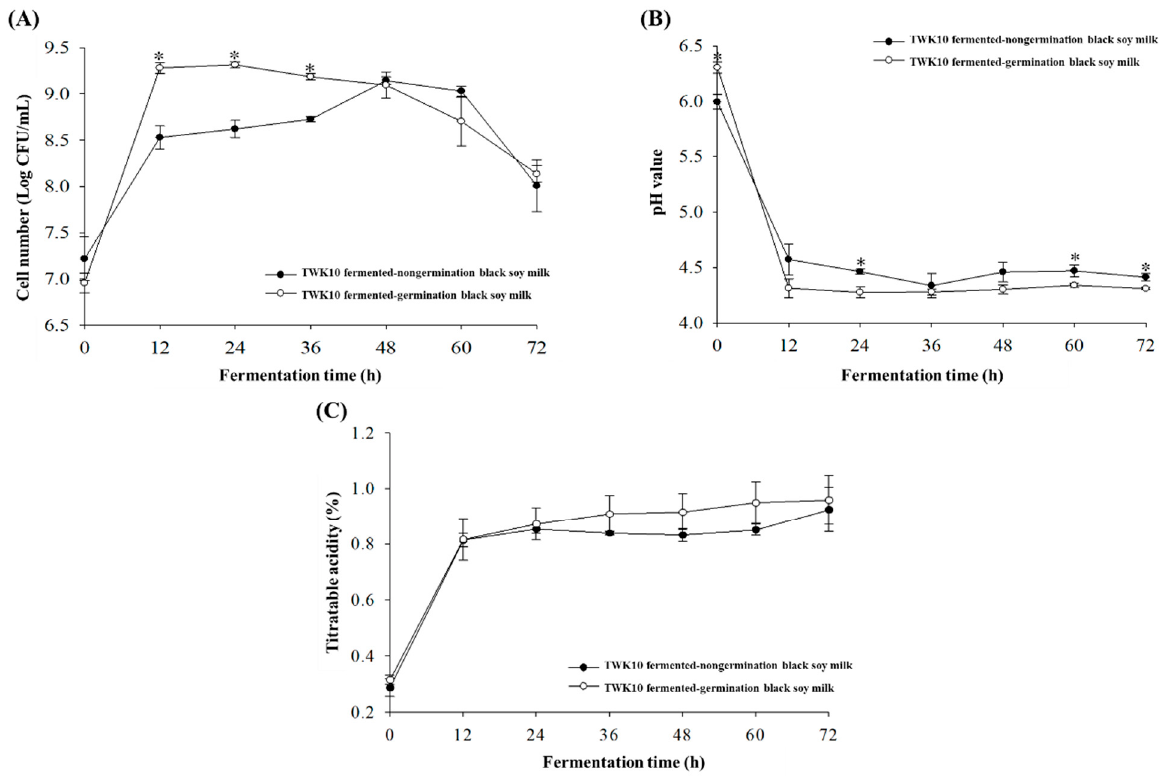
Figure 1. The growth curve ( A ), pH value ( B ) and titratable acidity ( C ) of TWK10 fermented-nongermination ( ● ) or TWK10 fermented-germination ( ) black soy milk. The data are presented as means ± SD ( n = 3). * represent significantly difference ( p < 0.05) according to a Sample t -test.